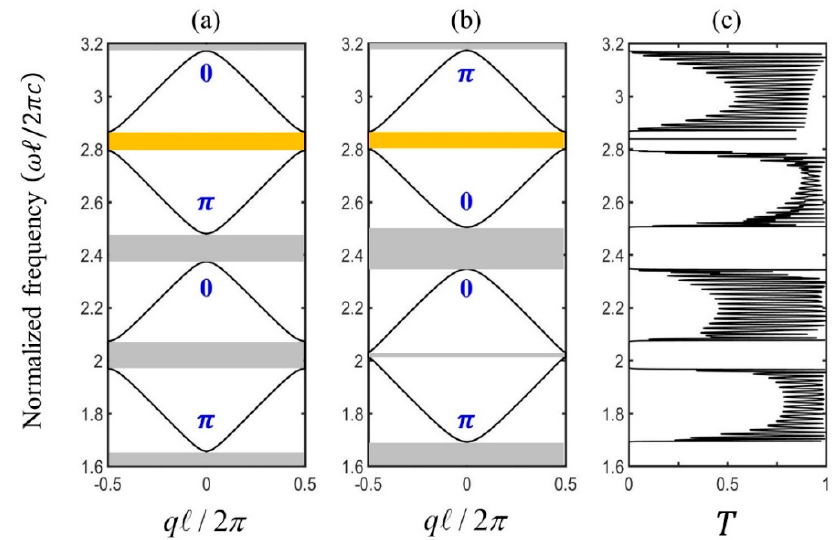
Figure 6. ( a , b ) are the band structures (black solid curves) of ES-I and ES-II. The band inversion occurs at orange strips. Zak phase (blue number) of each band is also marked at the center of the band in ( a ) and ( b ). ( c ) The transmission spectrum of a composite ES system composed of 20-unit cells on both sides of the interface. The sharp peak at 2.83 indicates the interface mode.